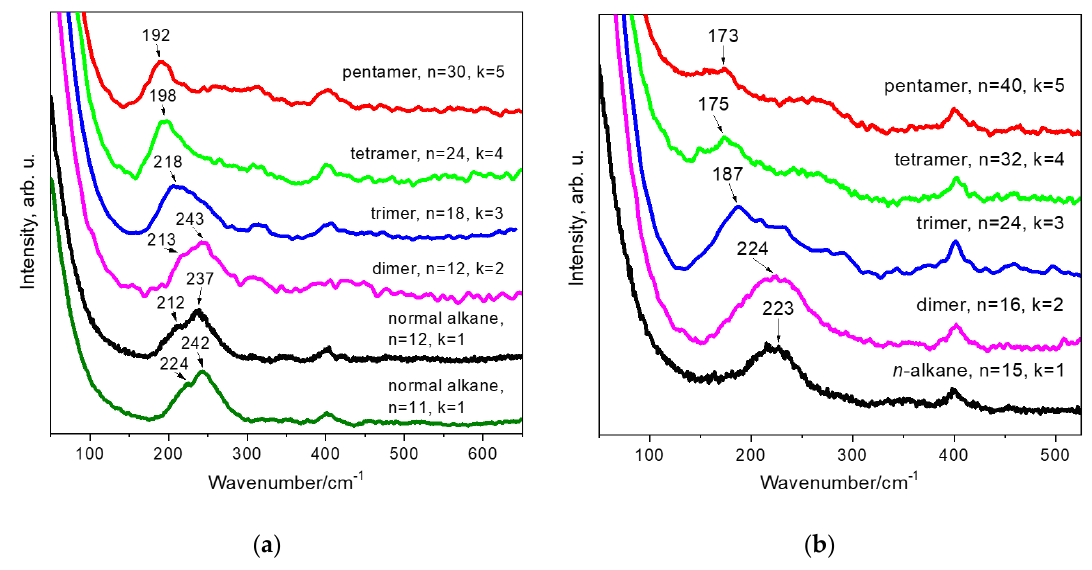
Figure 3. Raman spectra of the hydrogenated 1-hexene ( a ) and 1-octene ( b ) oligomers, as well as Raman spectra of linear alkanes C 11 H 24 , C 12 H 26 ( a ) and C 15 H 32 ( b ) in the region of the LAM and D-LAM.